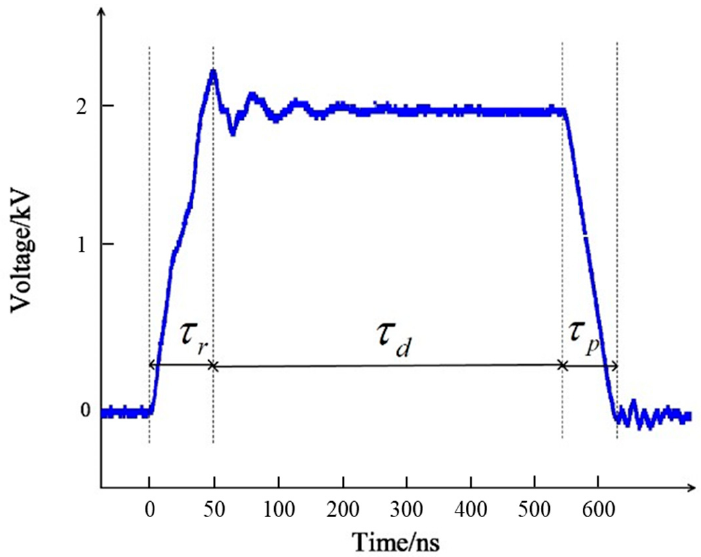
τ τ τ τ , fallen time p and pulse width , fallen time p and pulse width